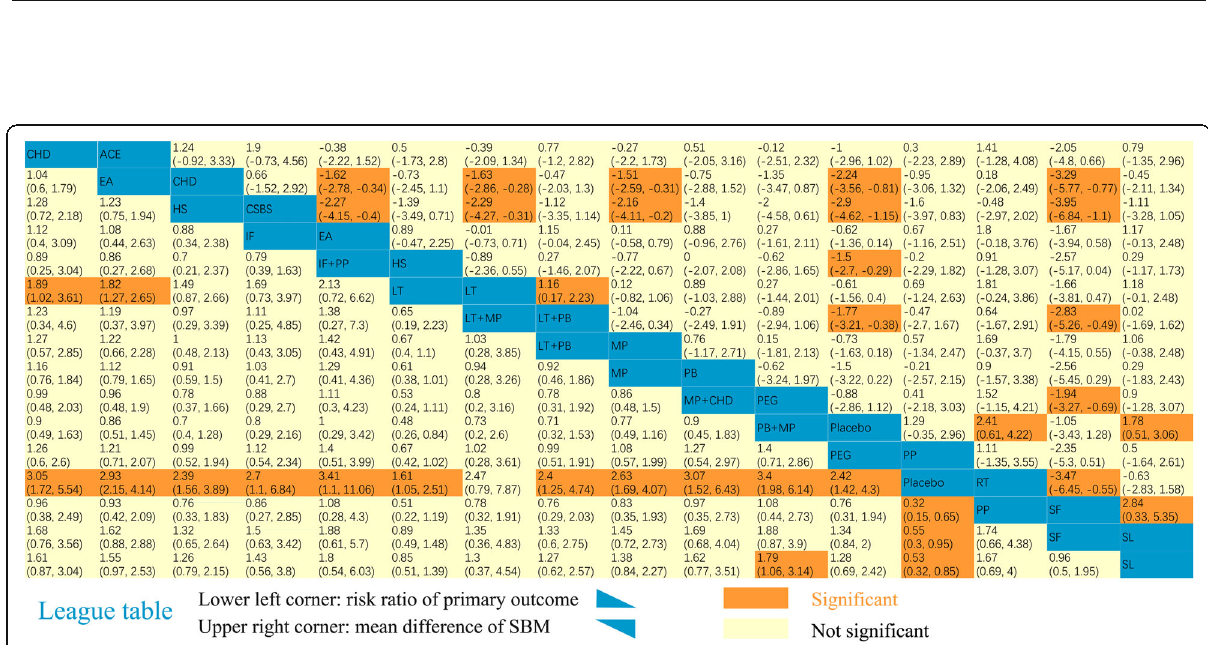
Fig. 5 Cumulative probability curves and SUCRA values. a The risk ratio of the responder rate. b The mean difference of the SBM count. c : The mean difference of the BS. d : Biplot of SUCRA values and P-scores of adverse effects